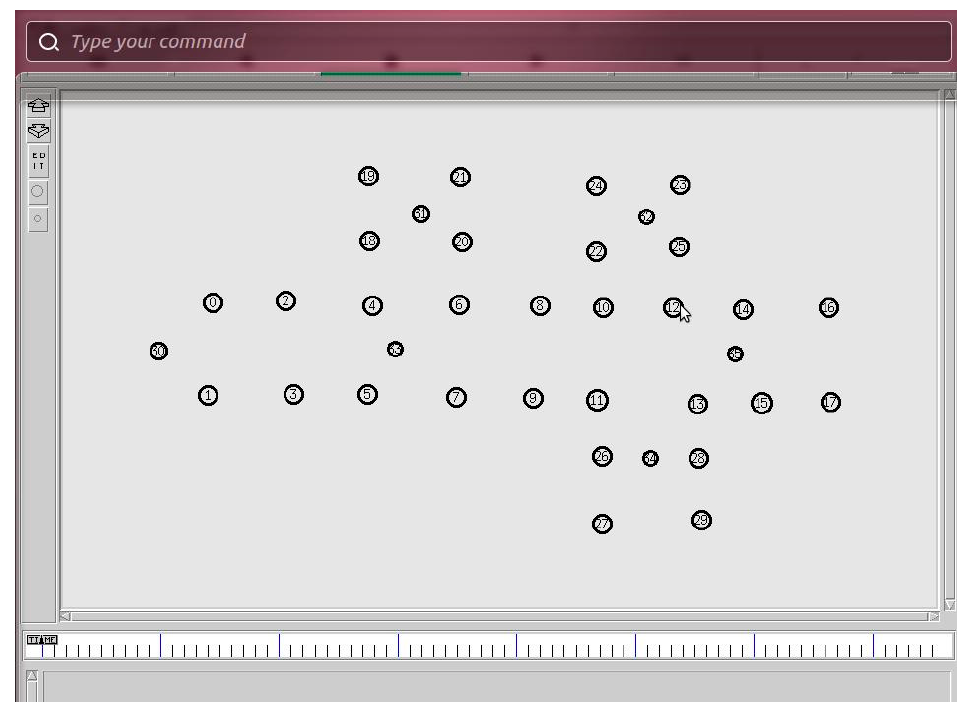
Figure 3. The layout of RSU (RoadSide Units) nodes.